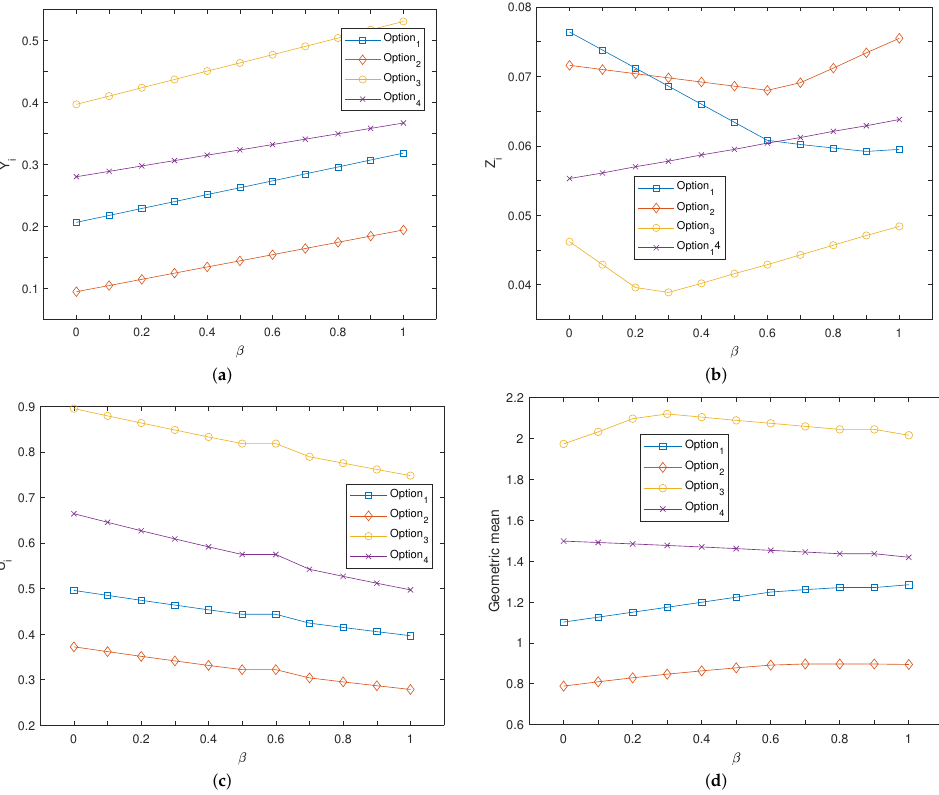
Figure 5. MULTIMOORA values under different weights, in which figure ( a ) corresponds to RSM, figure ( b ) corresponds to PRM, figure ( c ) corresponds to FMF and figure ( d ) is their geometric mean. Table 7. Qualitative and quantitative comparison